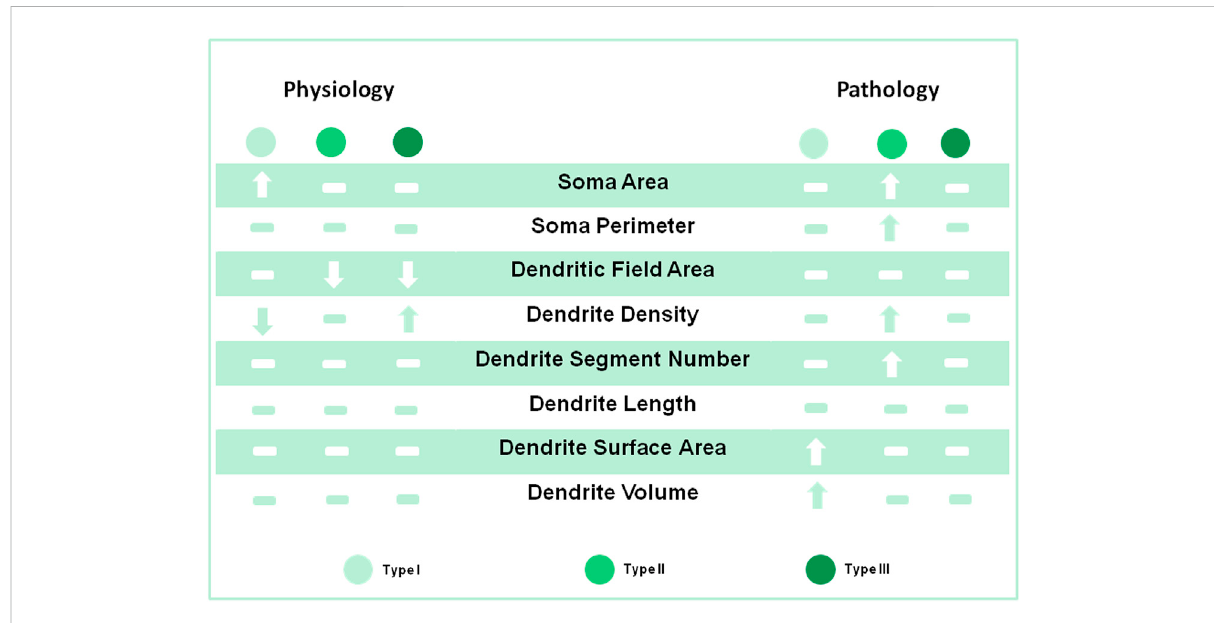
FIGURE 9 Summary of RGC morphological changes by KW6002 under physiological and pathological conditions The A 2A R antagonist KW6002 differentially altered these morphological parameters of different RGC types during normal and neonatal in fl ammation. The arrow means signi fi cant up or down-regulation by KW6002, while horizontal line means no signi fi cant